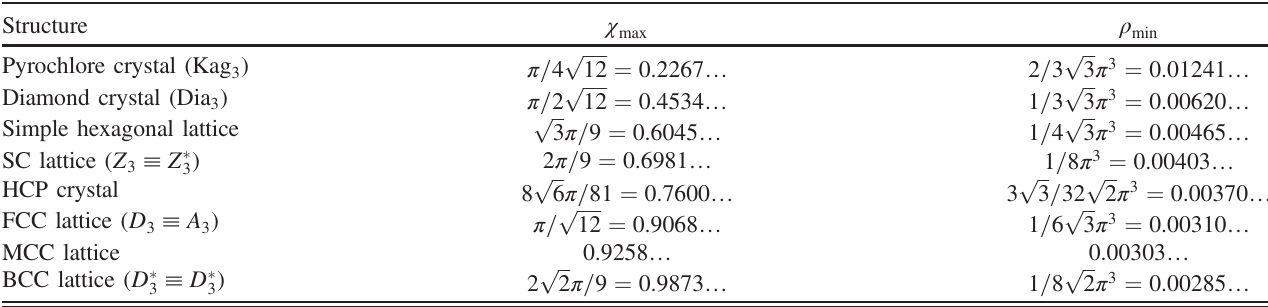
TABLE III. Maximum values of χ and corresponding minimum values of ρ for certain periodic stealthy ground states in R 3 with K ¼ 1 . Here, MCC refers to the mean-centered cuboidal lattice, which is a Bravais lattice intermediate between the BCC and FCC lattices and has an equivalent dual lattice [64]. The configuration with the largest possible value of χ corresponds to the BCC lattice.